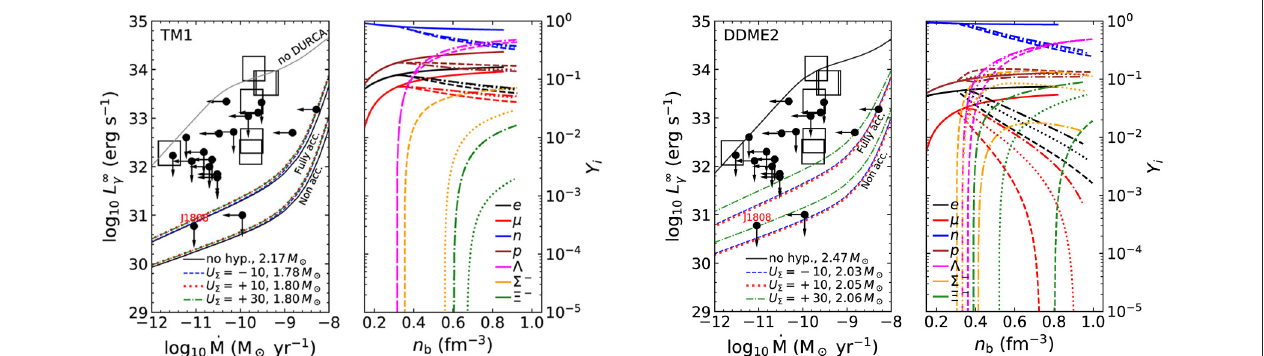
FIGURE 10 | For the TM1 (Left) and DDME2 (Right) parametrizations, the left panel of each plot shows the luminosity of NSs in SXTs obtained for different masses and EoSs vs the observational data taken from Beznogov and Yakovlev (2015). In the right panel the composition of each EoS that is employed is plotted. In addition to the purely nucleonic EoS for each parametrization (solid line), hyperonic EoSs with various values of the U 6 potential are employed: dotted, and dot-dashed lines, respectively). The NS maximum mass for which the lower bound of the luminosity of SXTs is obtained are indicated in the labels of the left panels of each plot. SAX J1808, with the lowest observed luminosity, is indicated in red.